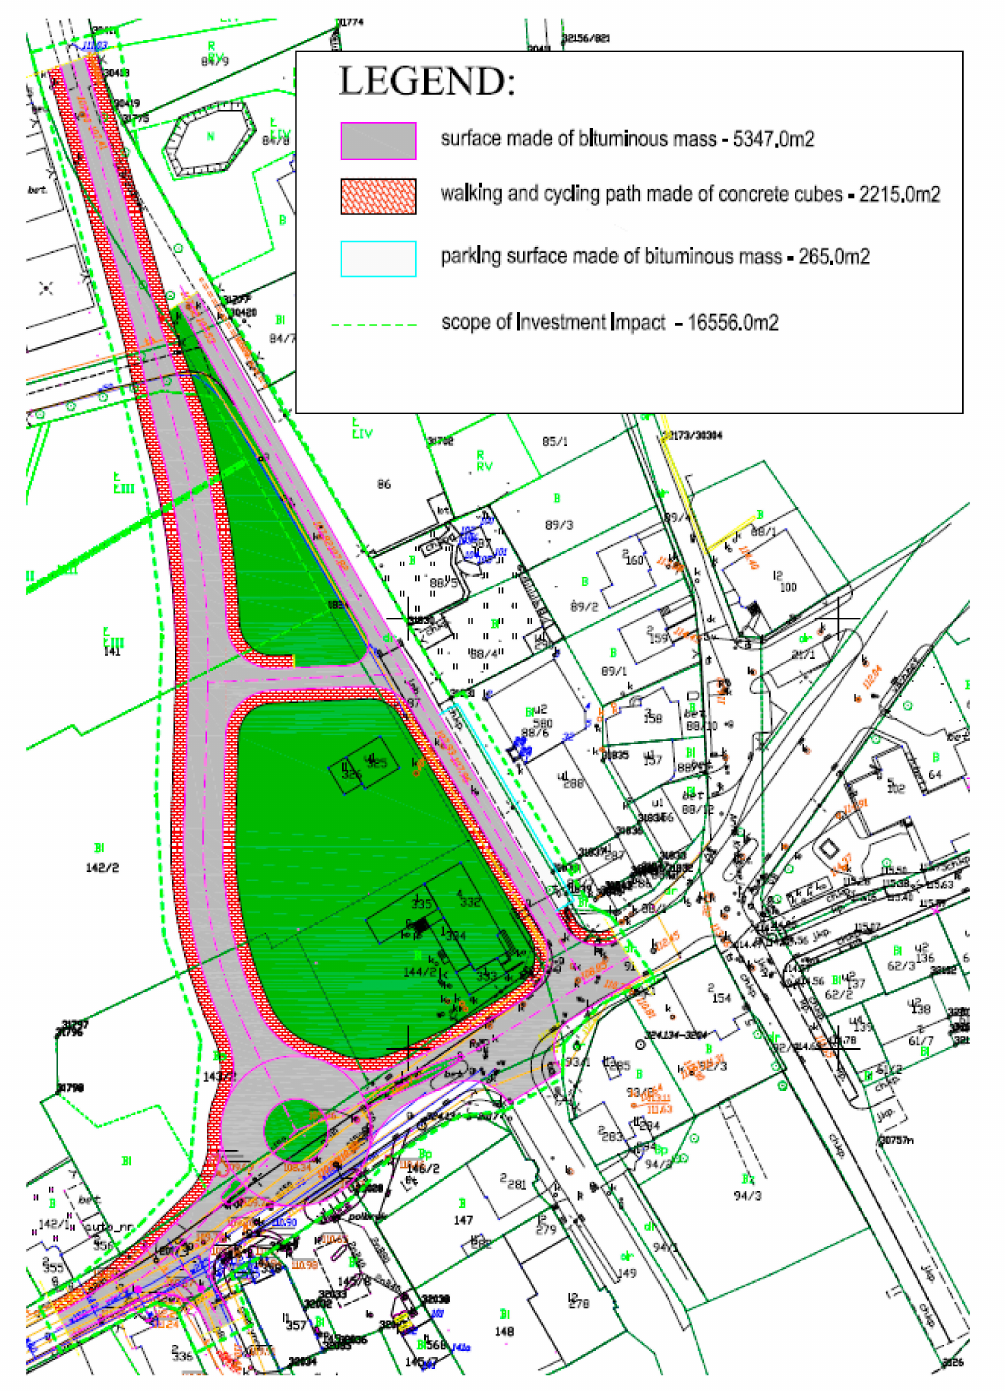
Figure 6. Site plan-proposed solution for the road layout at the intersection—option